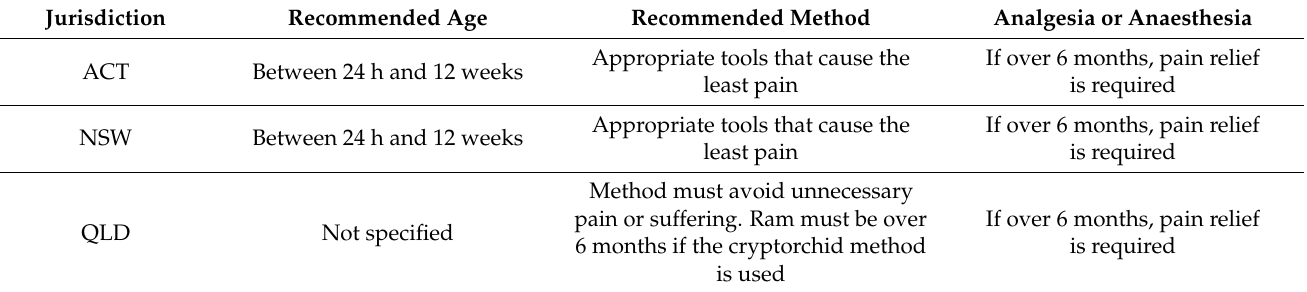
Table 3. Comparison of the recommended age, method, and pain relief for castration in sheep according to each jurisdiction’s code of practice for the welfare of